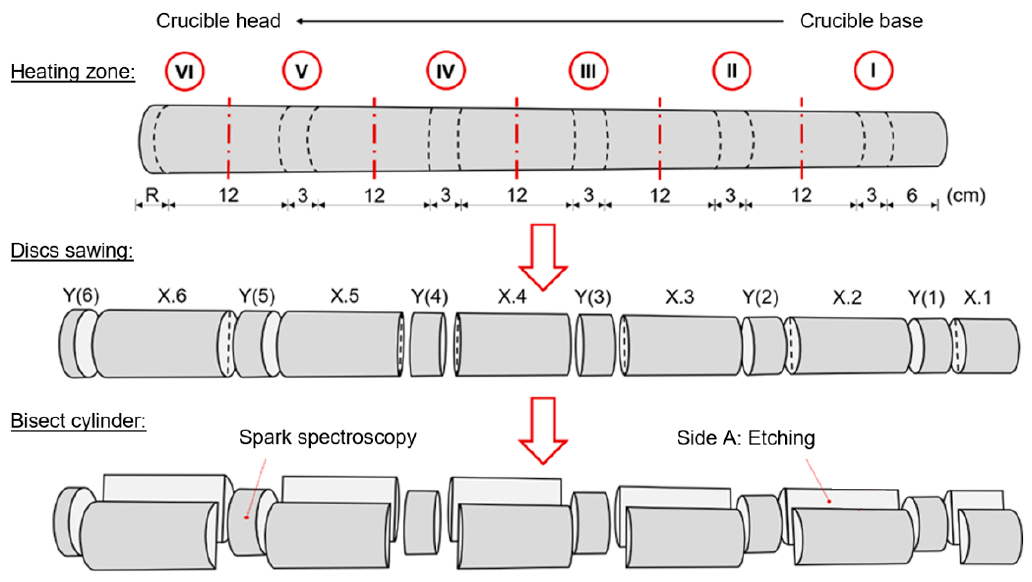
Figure 4. Schematics of the sampling for the macrographic and chemical analysis.